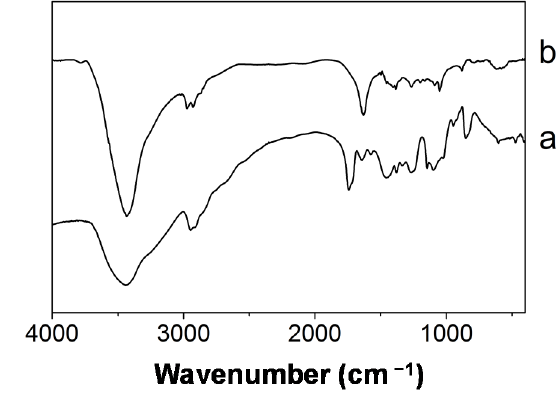
Figure 1. FT-IR spectra of samples. ( a ) SiO 2 -TiO 2 gel fiber; ( b ) PVA/SiO 2 -TiO 2 hybrid fiber.